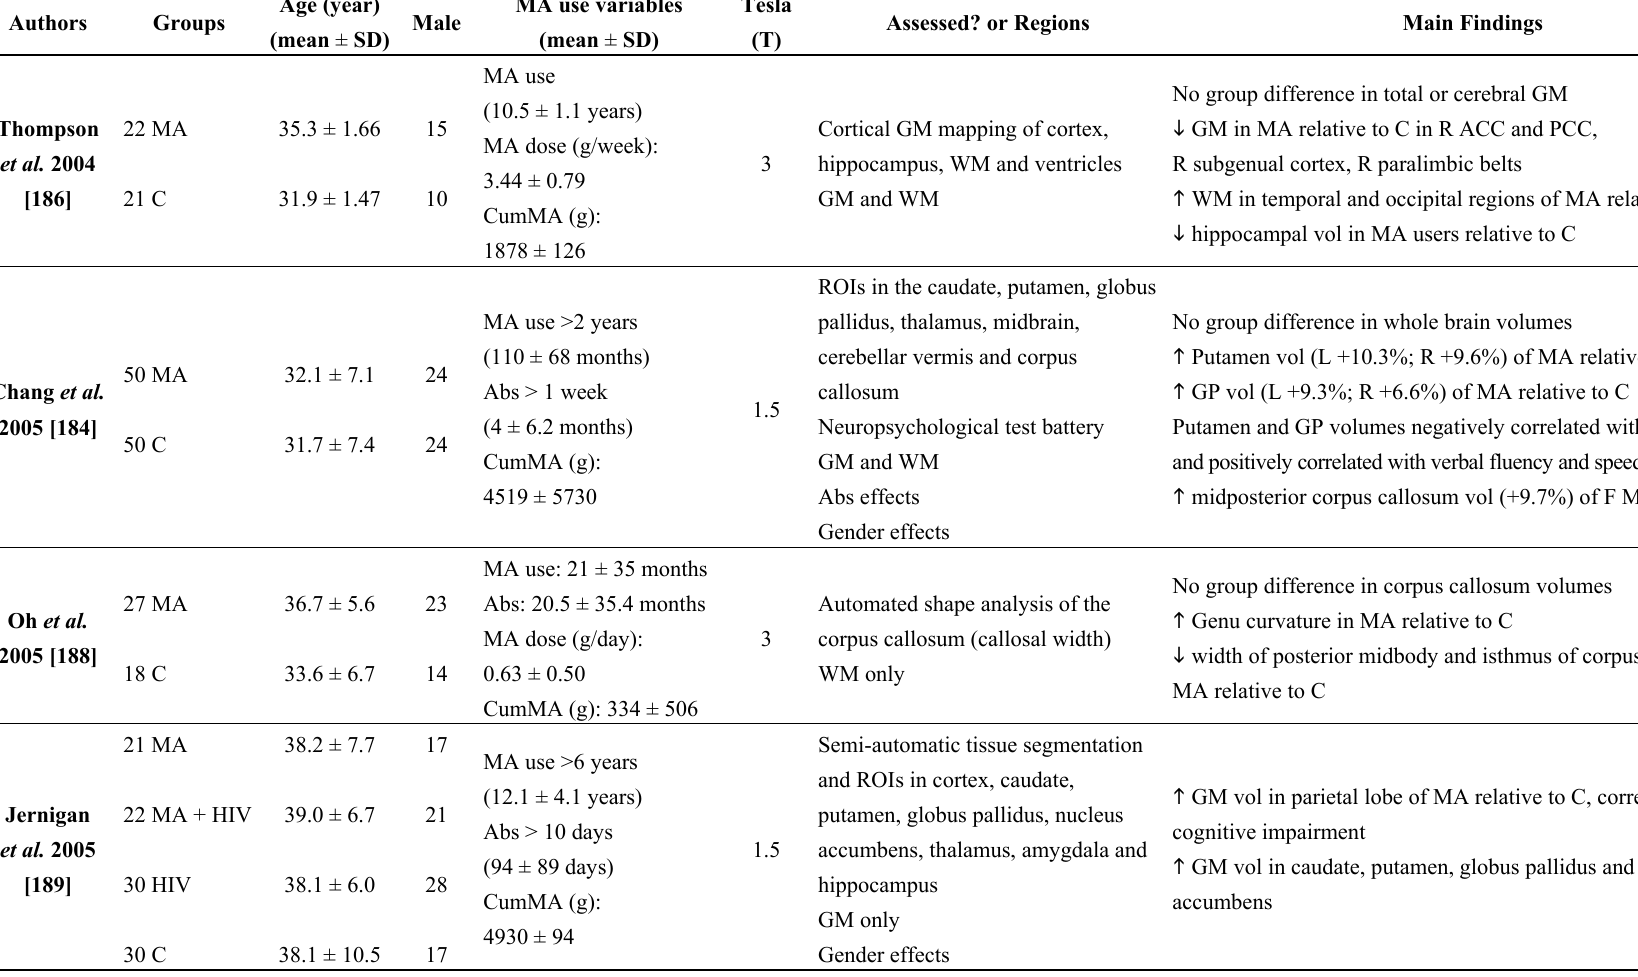
Table 3. Summary of study specifications and findings from structural MRI studies of MA